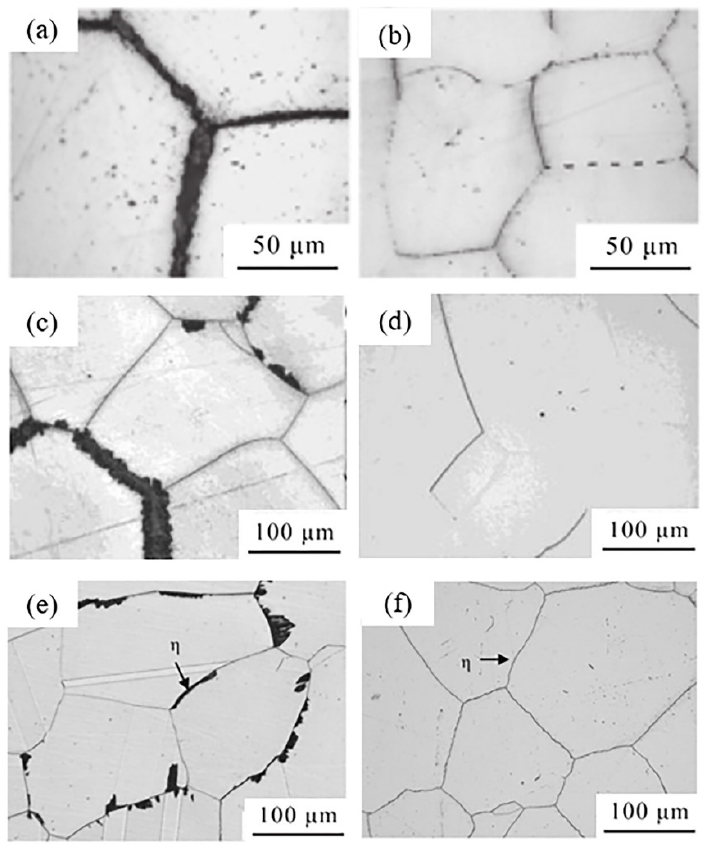
Figure 7. Optical micrographs: ( a ) FeNiCoAlNb; ( b ) FeNiCoAlNb-0.05B; ( c ) FeNiCoAlTa; ( d ) FeNiCoAlTa-0.05B; ( e ) FeNiCoTi; ( f ) FeNiCoTi-0.02B [60,63,68]. Reprinted with permission from Ref. [60], Ref. [63] and Ref. [68]. Copyright 2013 Elsevier and 2015 Elsevier.